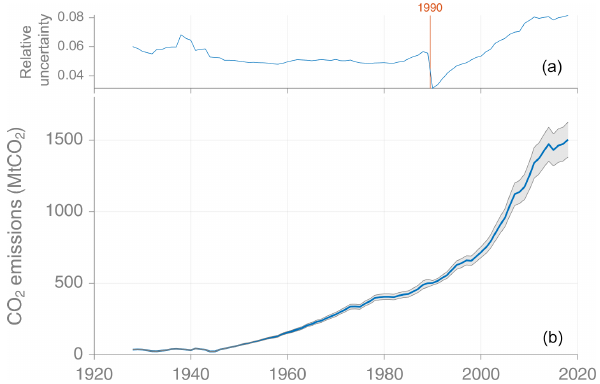
Figure 4. Comparing new cement emissions estimates (dashed lines) for the top four cement producers after China with those from CDIAC (solid lines) and official estimates (crosses, India and Viet Nam) as reported to the UNFCCC (see text). The new estimates for the USA and Turkey come directly from national official estimates. Estimates from EDGAR v4.3.2_FT2015 are shown for India and Viet Nam with round